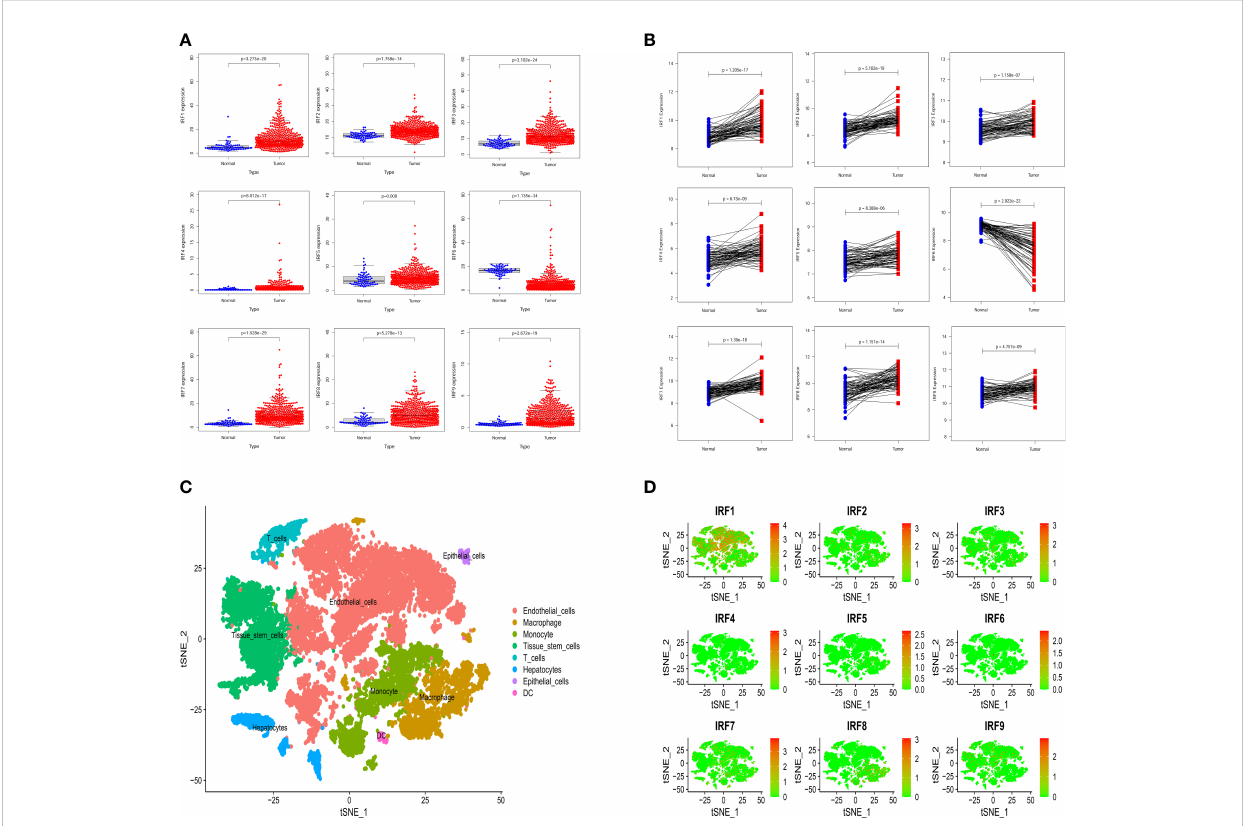
FIGURE 1 The expression levels of the IRF family members between ccRCC samples and normal samples. (A) The mRNA expression levels of the IRF family members in the TCGA-KIRC dataset. (B) The mRNA expression levels of the IRF family members in the GEO dataset. (C) The cell types were identi fi ed by single-cell RNA-sequencing analysis. (D) The expression levels of the IRF family members in different types of cell